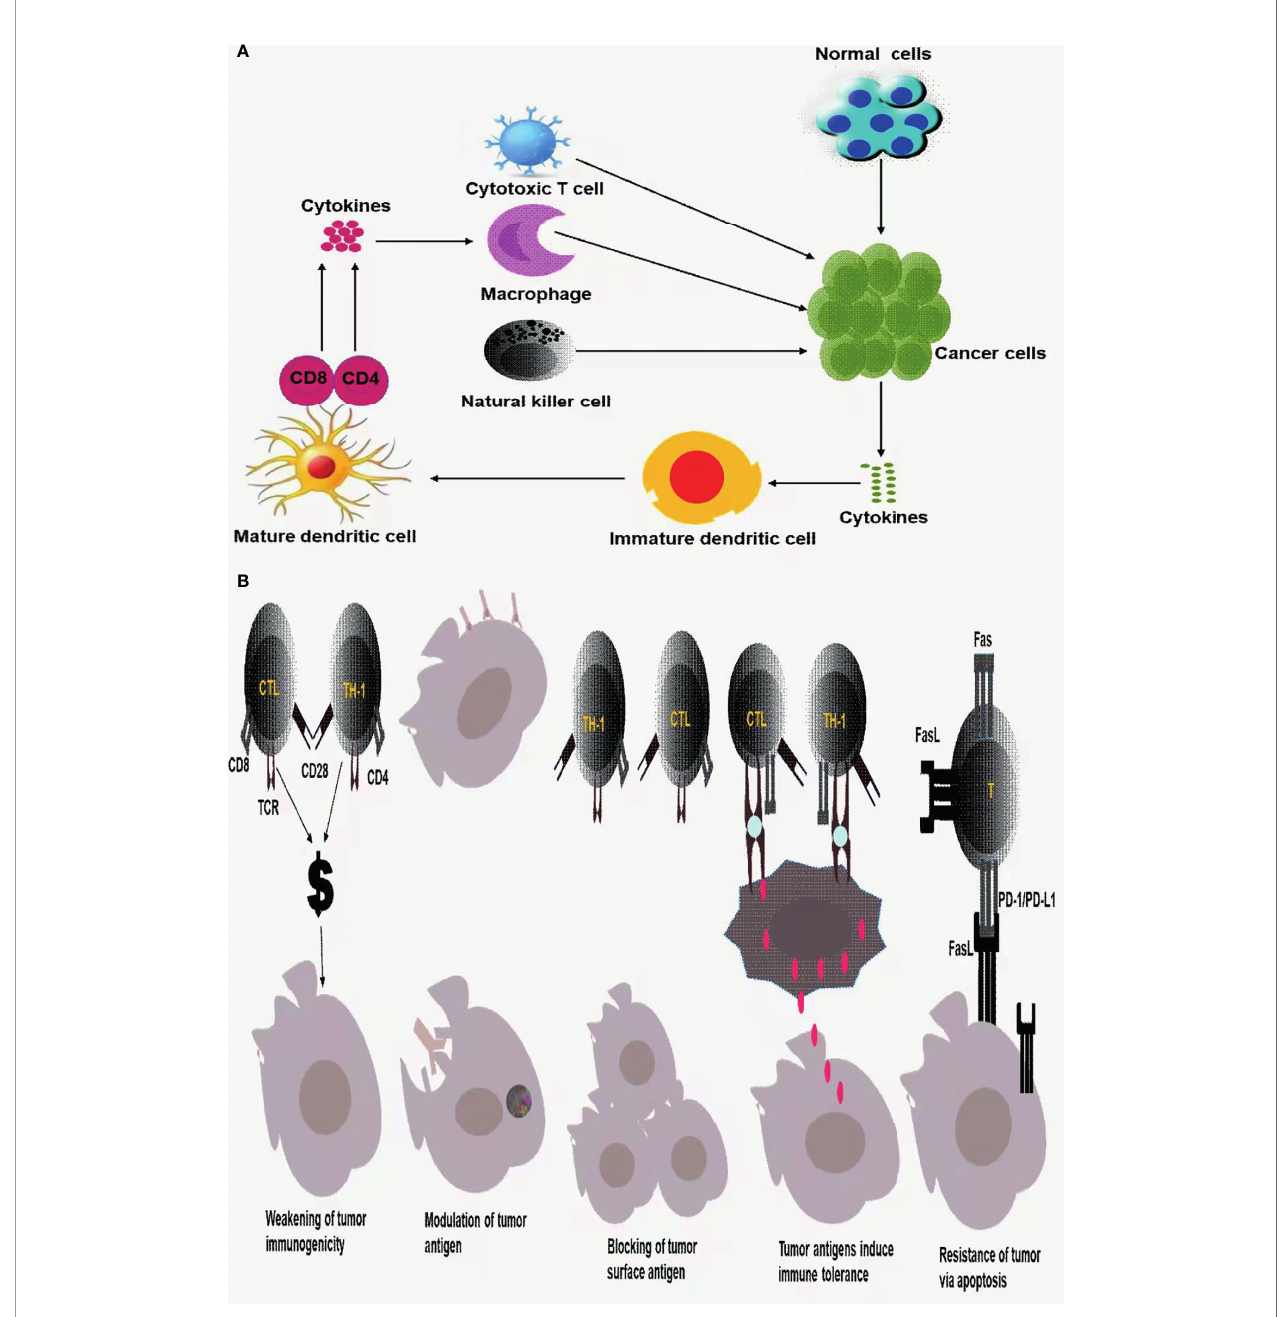
FIGURE 1 | (A) Innate immune response and adaptive immune response to tumor cells; (B) tumor immune escape